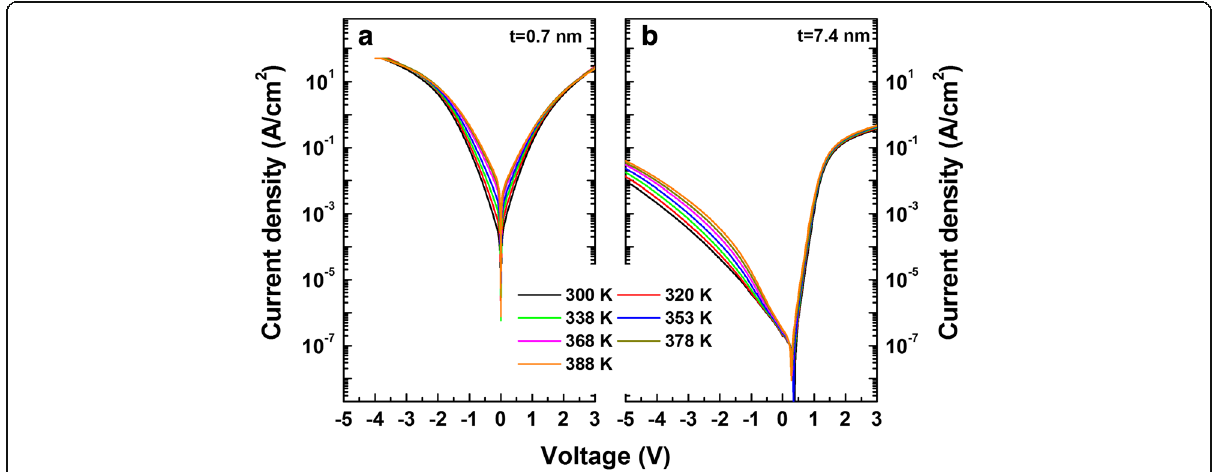
Fig. 7 Temperature-dependent current density – voltage ( J – V ) characteristics for the samples with a 0.7- and b 7.4-nm-thick AlN